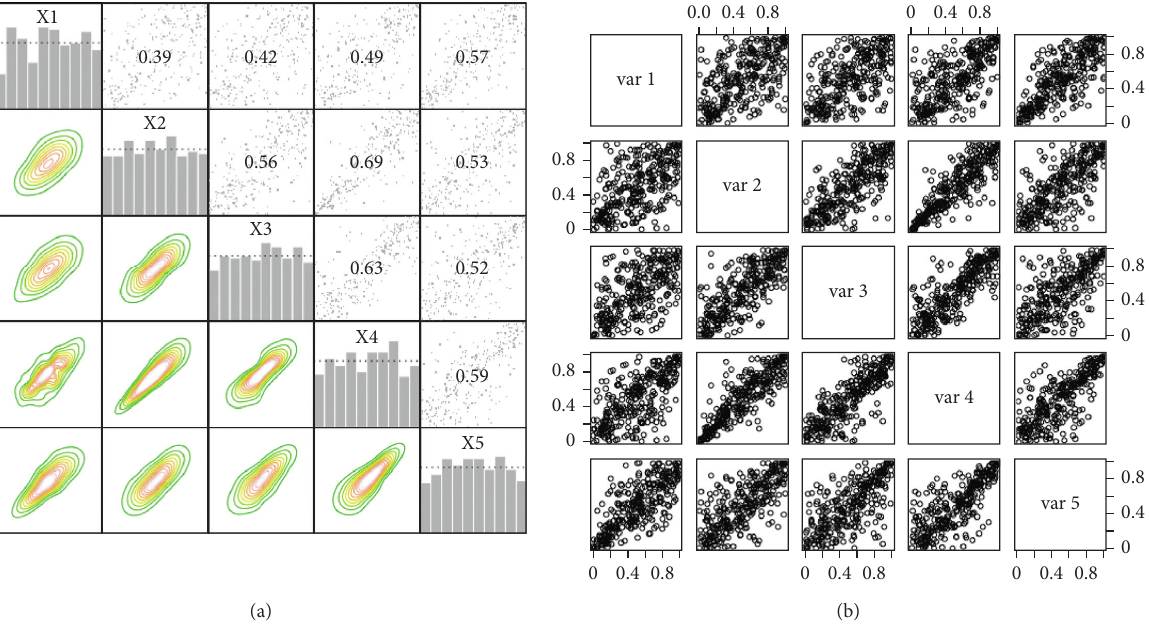
Figure 4: (a) The contour (lower triangular), scatter plot (upper triangular), and the correlation computed by Kendall’s tau (the diagonal). (b) The scatter pair plot of the simulated data based on the mixture of R-vine densities.